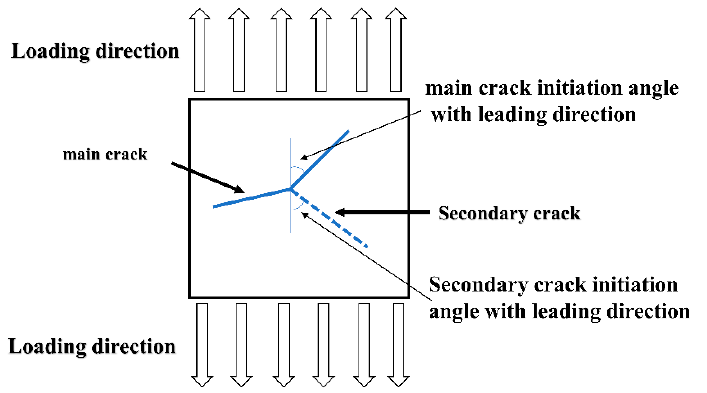
Figure 10. The simplified model 2 of crack propagation.